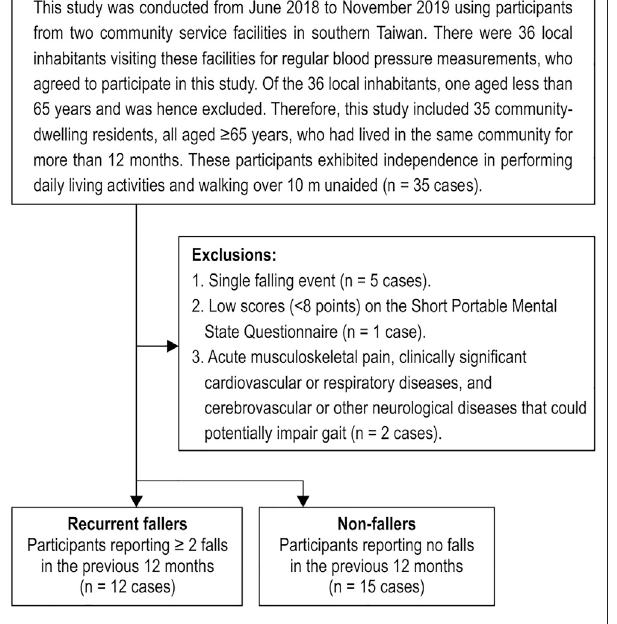
FIGURE 1 | Flow chart illustrating the inclusion and exclusion criteria of the study